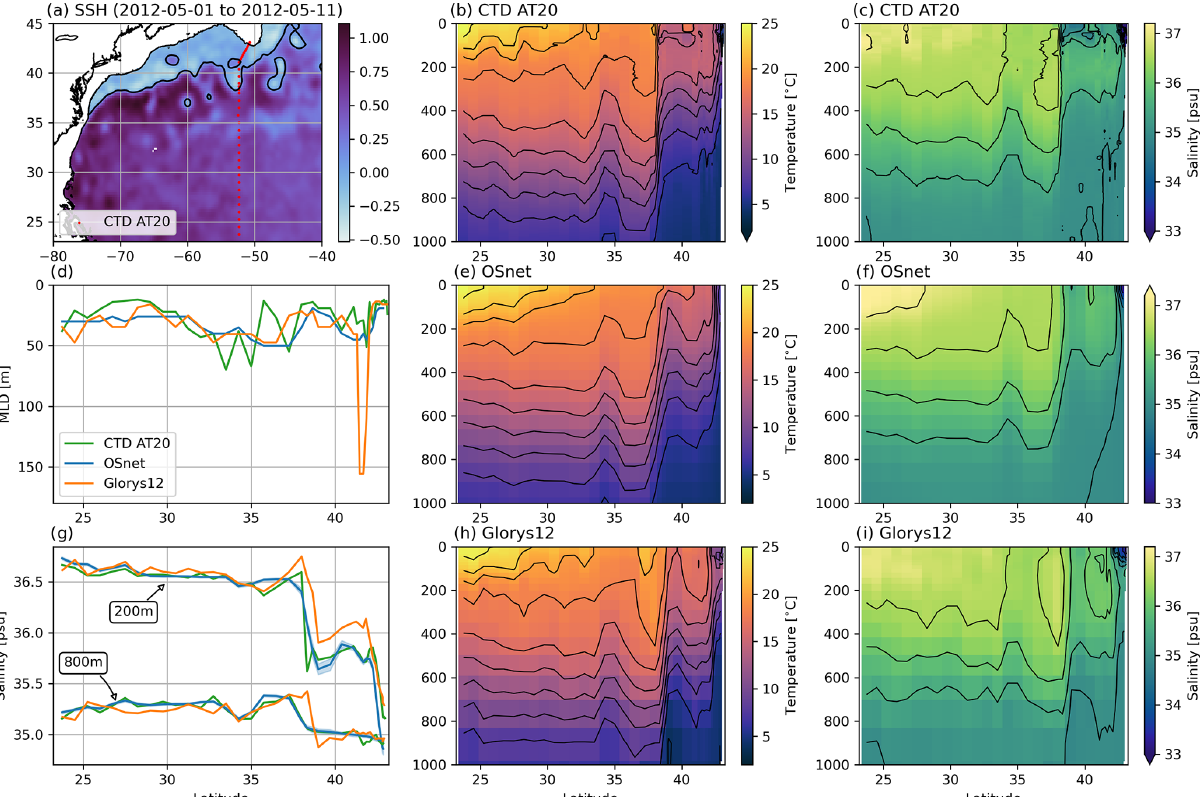
Figure 15. Hydrographic section AT20 (a, b, c) sampled along the 52 . 3 ◦ W meridian by the research vessel Atlantis from 1 to 5 May 2012. Temperature and salinity profiles are estimated with OSnet (e, f) at the exact locations of the sampled CTDs by interpolating the input data at those locations. Glorys12 profiles (h, i) are collocated in time and space with the CTD profiles. The SSH in panel (a) is averaged over the sampling period of the section. The MLDs in panel (d) are computed with the density threshold of 0.03. Salinity segments at 200 and 800m are plotted along latitude in panel (g) with confidence intervals in blue bands around the mean value for OSnet, i.e., the standard deviation of the 15 bootstrapped models. The contour intervals for the plot section are 0.5psu from 33 to 37psu for salinity and 2 ◦ C from 4 to 24 ◦ C for